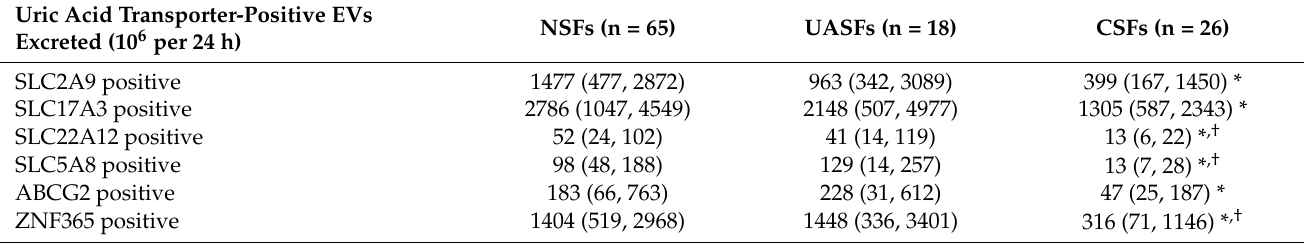
Table 2. Twenty-four-hour excretion of urinary extracellular vesicles (EVs; microvesicles and exo- somes) bearing six uric acid (UA)-transporters from UA stone formers (UASFs) and calcium stone